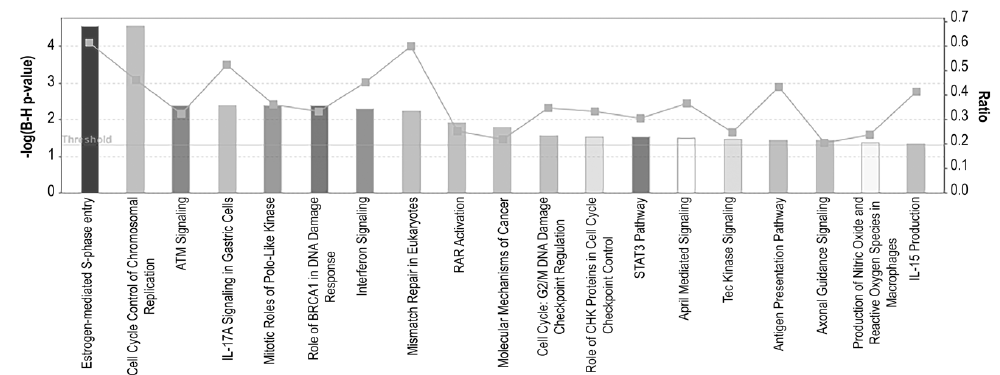
Figure 4. Canonical pathway analysis of ER+ palbociclib-resistant breast cancer cells. A higher–log(B- H p -value) shown on the left Y axis represents more significant pathways. The ratio (right Y axis) refers to the number of genes from the data set that map to the pathway divided by the total number of genes that map the canonical pathway from the Ingenuity Pathway Analysis (IPA) database. pval ≤ 0.05; qval ≤ 0.05; | log 2 FC | ≥ 1.